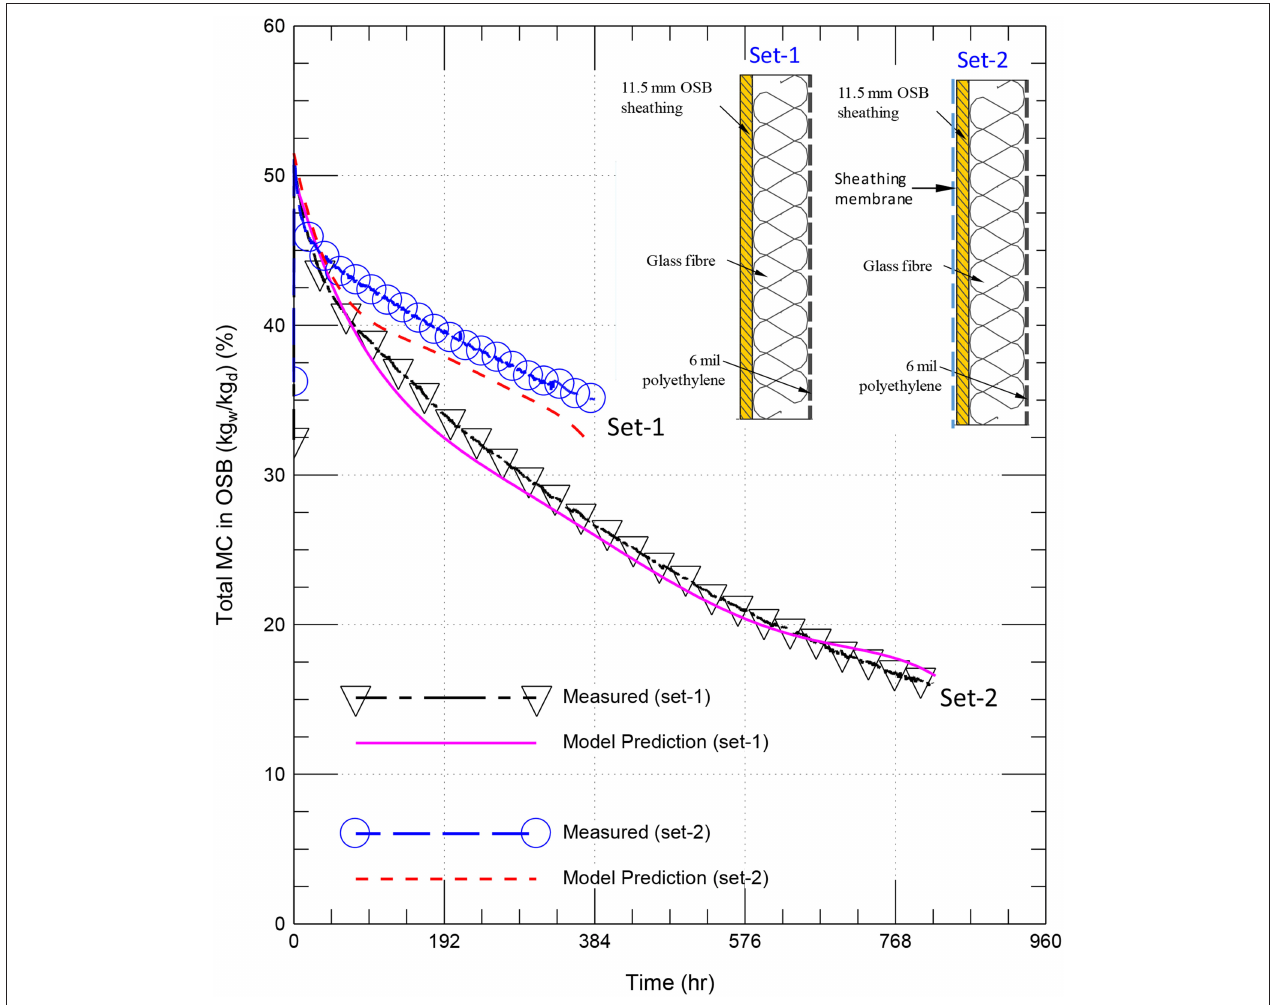
FIGURE 3 | Drying curves of the OSB in set-1 and set-2